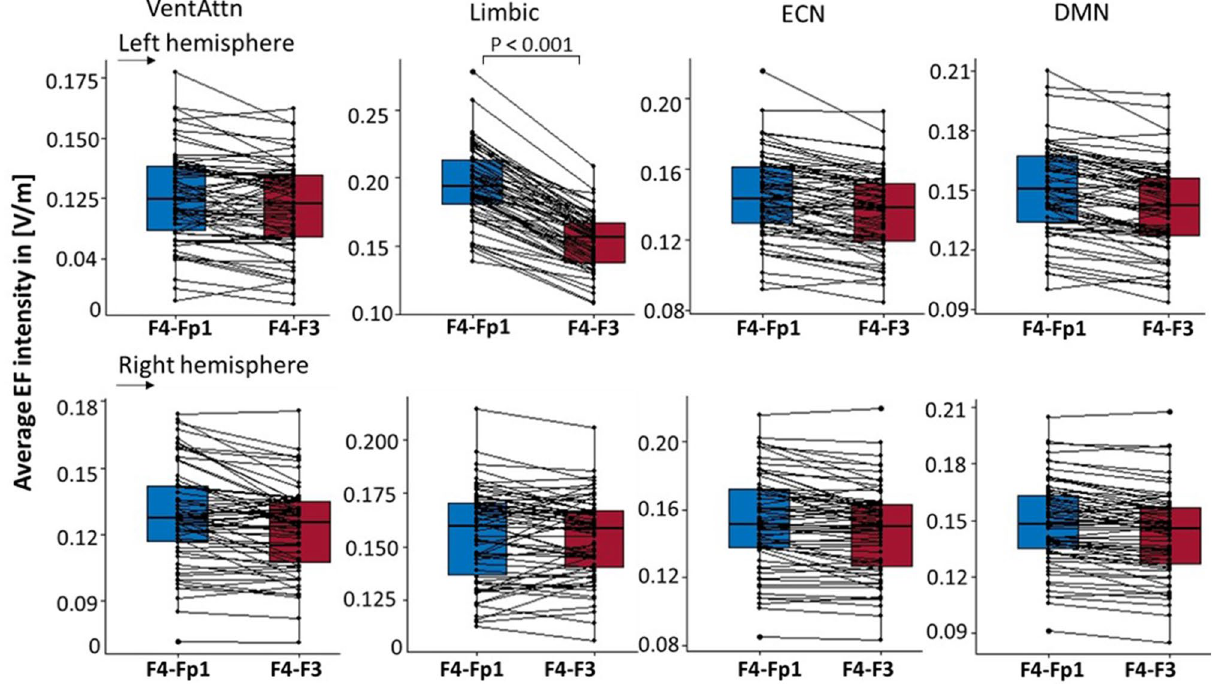
Figure 6. Group-averaged EF intensity for two montages: F4–Fp1 (blue) and F4–F3 (red). Average EF intensity calculated for all 66 subjects inside the large-scale brain networks; first row for left and second row for the right hemisphere. Results are visualized for the networks with average EF above the threshold. Boxplot showing the effects of electrode montage on averaged EF intensity in [V/m] (n = 66 each). Dots represent the data for individual subjects. Significant P values after FDR correction for between montage differences are reported above boxplots. VentAtn ventral attention network, Limbic limbic system network, ECN executive control network, DMN default mode